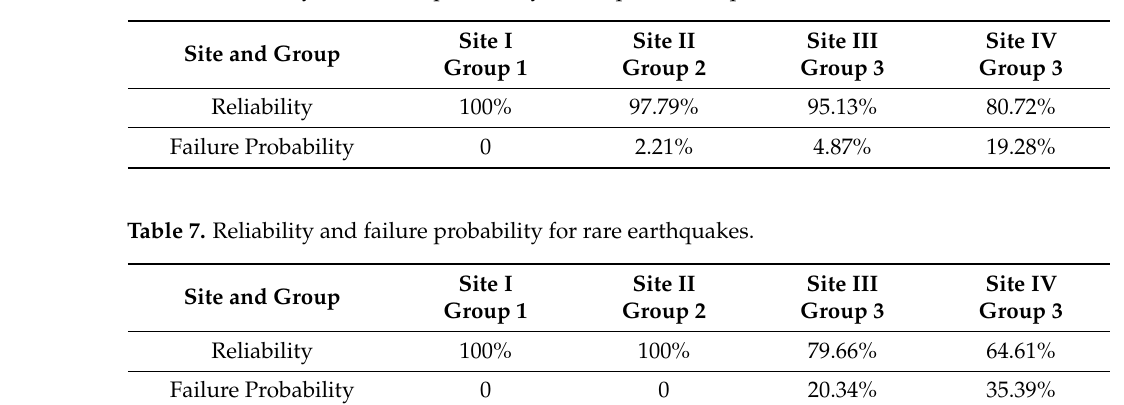
Figure 19. Extreme value distributions of story drift angle under different groups of stochastic simulated seismic ground motions: ( a ) frequent earthquake ( b ) rare earthquake. Table 6. Reliability and failure probability for frequent earthquakes.